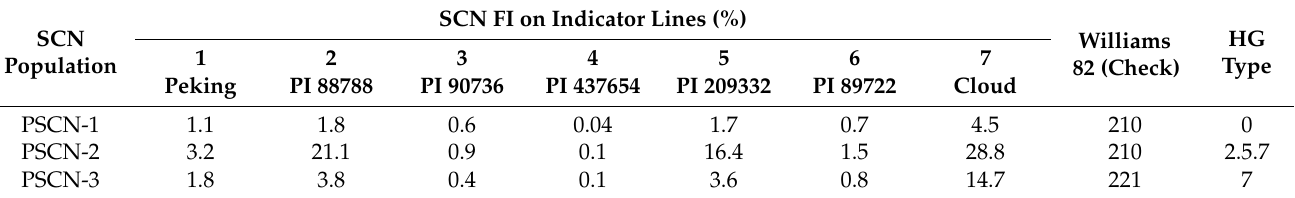
Table 1. Female index (FI) of Heterodera glycines populations used in the study. SCN FI on Indicator Lines SCN